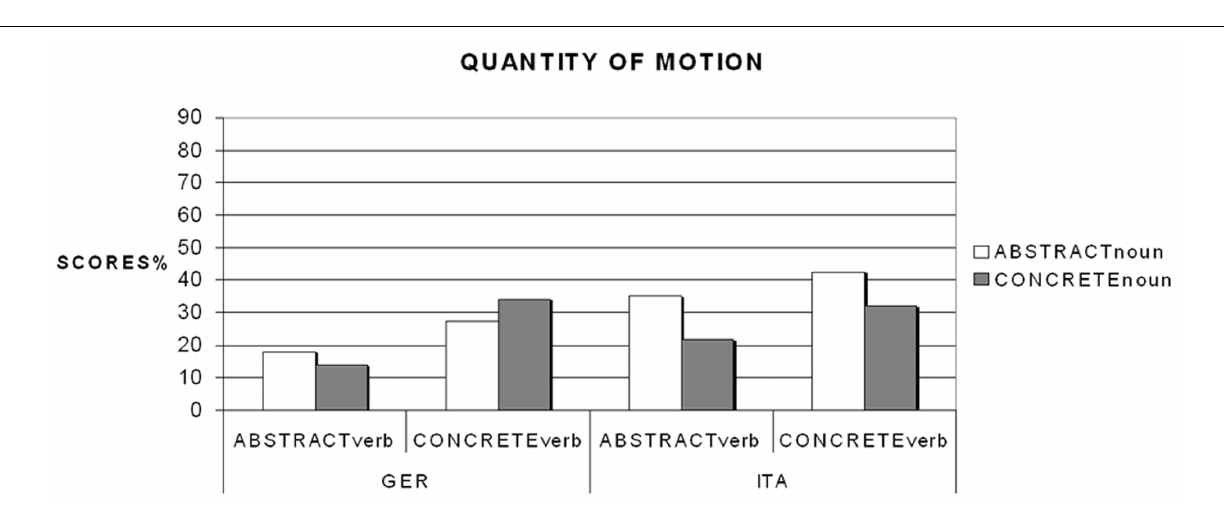
main difference concerns the ConcreteVerb plus Abstract Noun vs. Concrete